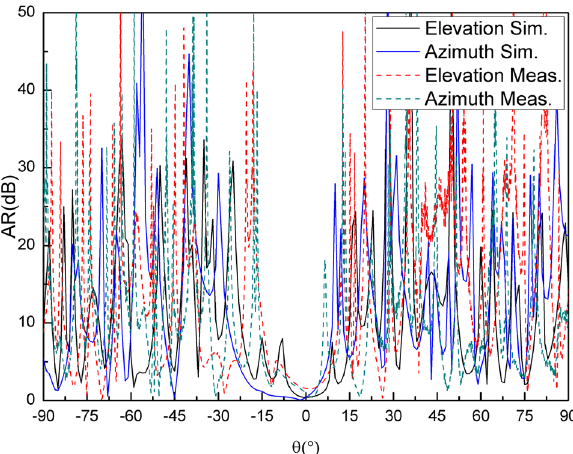
Figure 13. Comparison of measured and simulated axial ratio patterns.